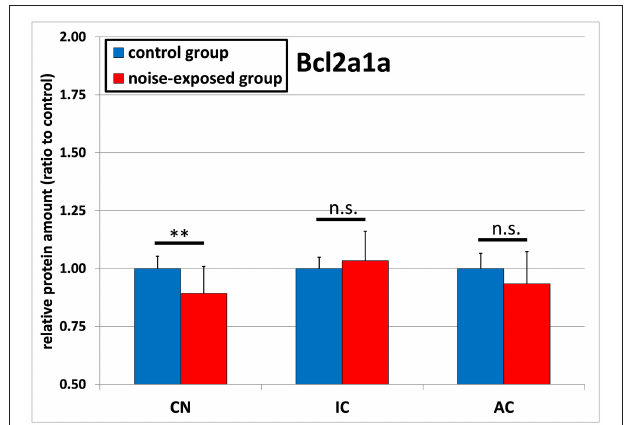
FIGURE 4 | Relative protein amounts of APAF1. Presented are ratios to the respective controls from the Western blot experiments (mean ± S.D.) in the cochlear nucleus (CN), inferior colliculus (IC) and auditory cortex (AC) of the mouse central auditory pathway immediately after noise trauma compared to unexposed controls (n.s., no significant difference between